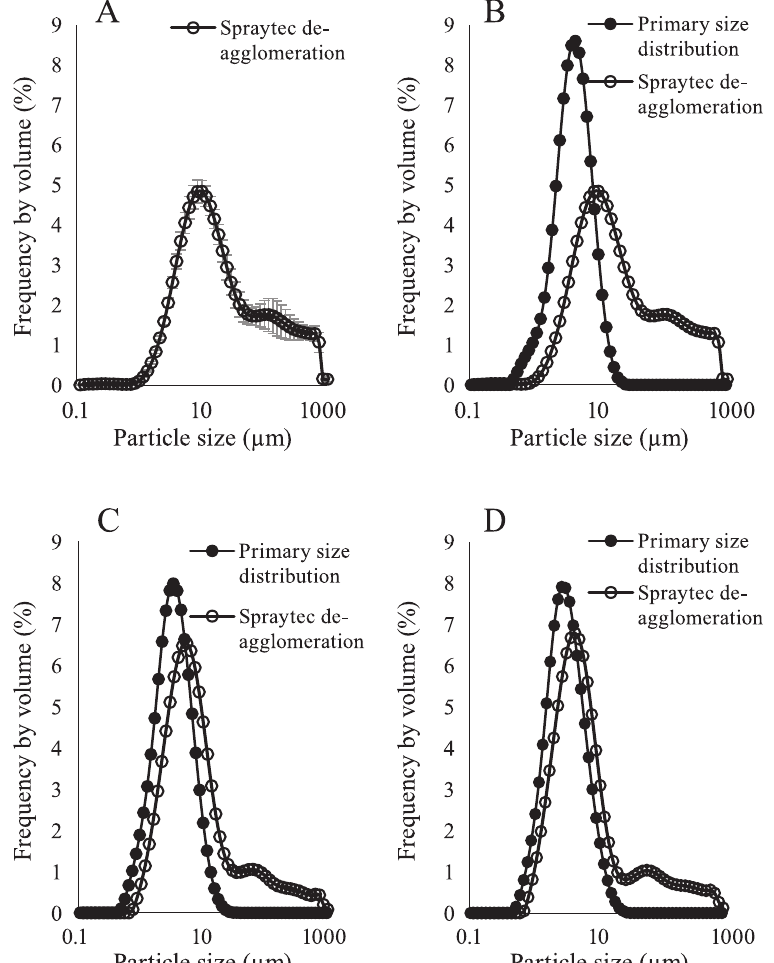
Fig. 1 Particle size distributions of the aerosol plume of uncoated (B), 2 % w/w magnesium stearate (MgSt) coated salbutamol sulphate (SS) batch 1 (C) and batch 2 (D) determined using the Malvern Spraytec ® when dispersed from a Rotahaler ® at 60 L/min and their primary particle size distributions determined by laser diffraction (Malvern Mastersizer ® 2000) in liquid medium. The variability of uncoated SS de-agglomeration in Spraytec determination has been shown with error bar in (A). ( n = 5, data represent mean ± standard